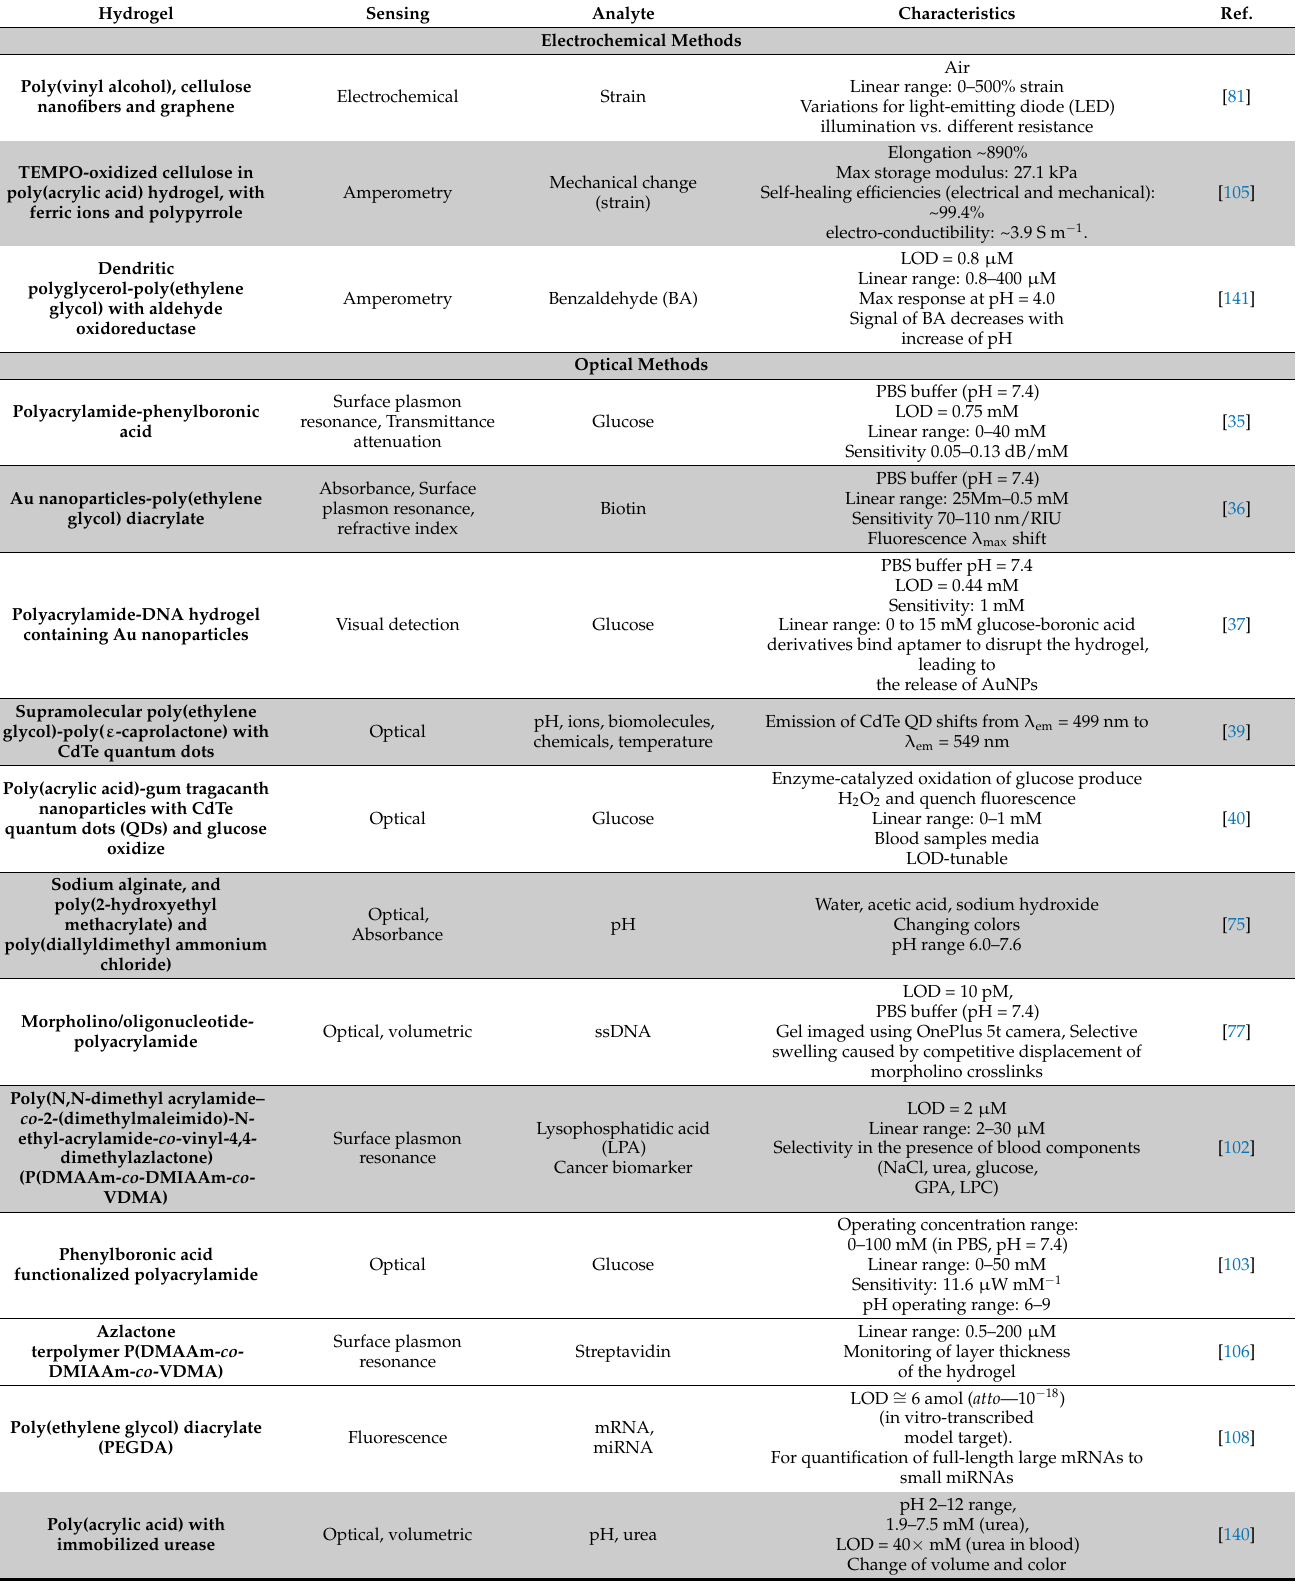
Table 2. Synthetic hydrogel-based